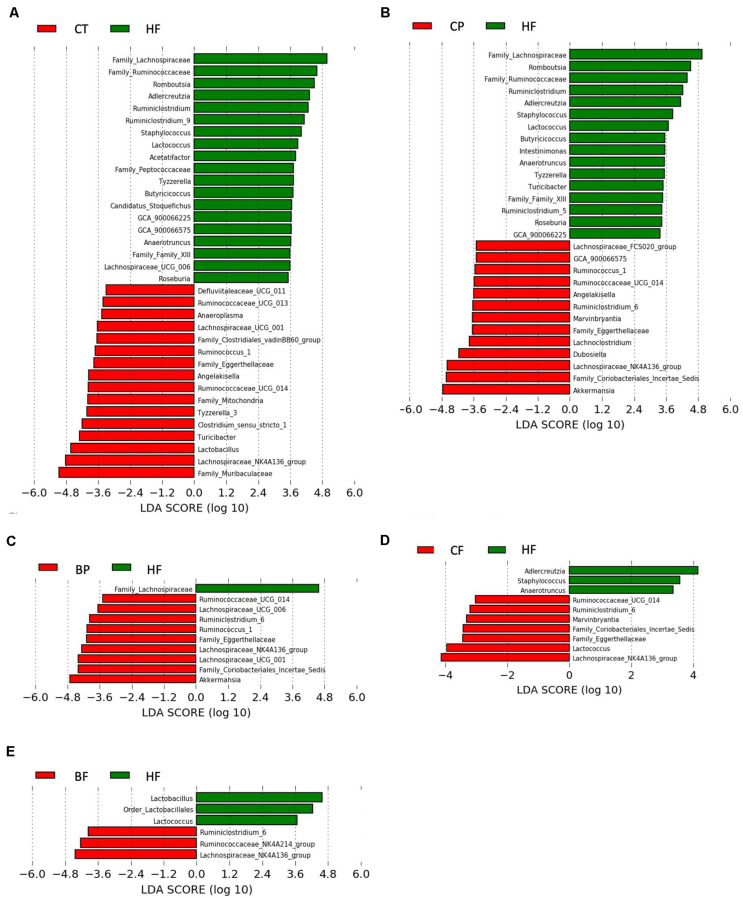
Bacterial biomarkers in mice fed the polyphenol-rich CP and BP and their fiber-rich CF and BF. Key phylotypes were identified using linear discriminant analysis (LDA) combined with effect size (LEfSe) algorithm. (A) LEfSe analysis showing taxa distinguishing Chow-fed mice (CT) as compared to HFHS (HF); (B) Taxa distinguishing mice fed polyphenol-rich whole cranberry powder (CP); (C) Taxa distinguishing mice fed polyphenol-rich whole blueberry powder (BP); (D) Taxa distinguishing mice fed fiber-rich cranberry fraction (CF); and (E) Taxa distinguishing mice fed fiber-rich blueberry fractions (BF). Threshold for LDA score was 2.0. Positive LDA (green bars) are enriched in HF, while negative LDA (red bars) are enriched in CT, CP, BP, CF, and BF as shown on figure legends (n = 12 mice per group). Statistically significant taxa enrichment was obtained with Kruskal–Wallis test among classes (p-value = 0.05).